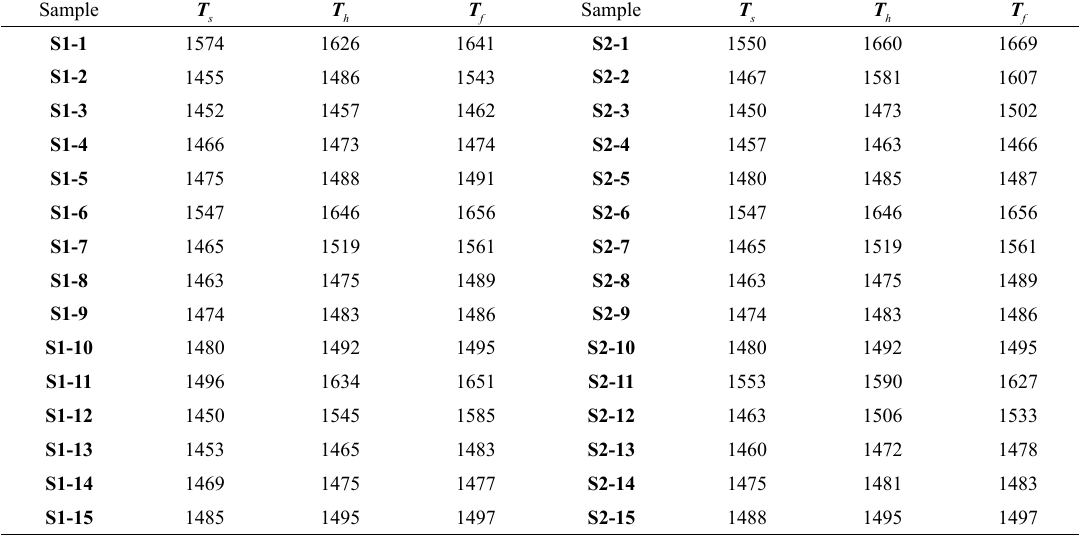
Table 2. Measured characteristic temperatures for various samples (K). Sample